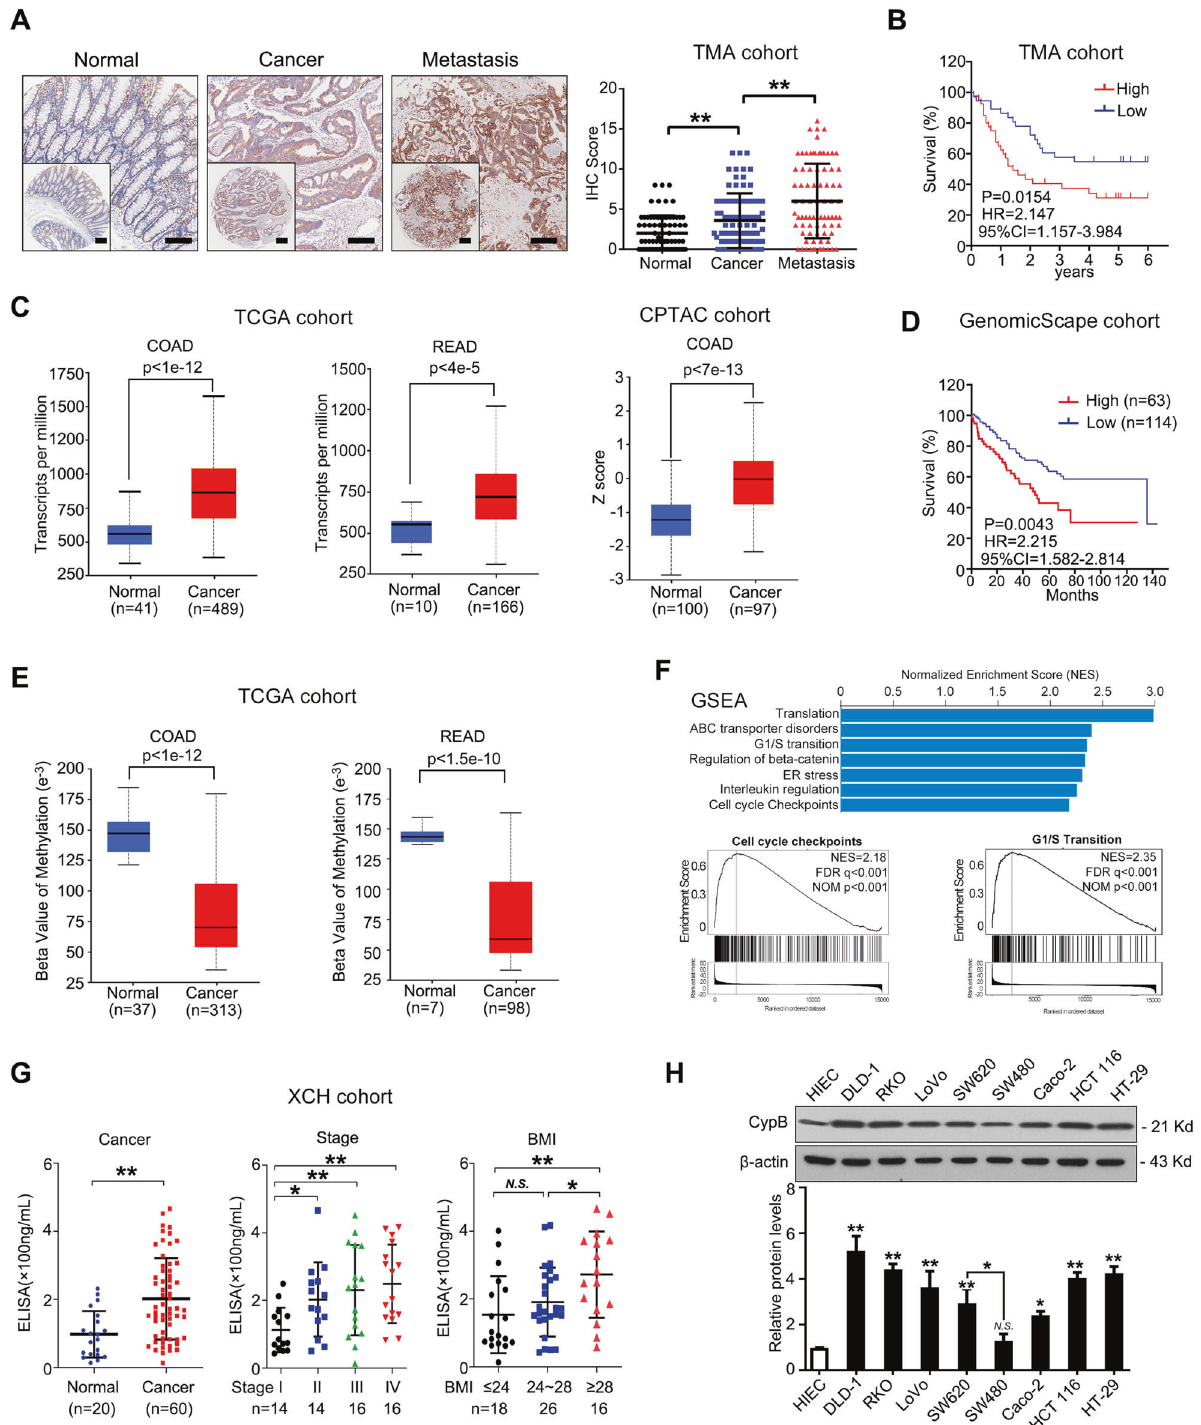
Fig. 1 CypB is upregulated in CRC and predict poor survival. A Left: Representative images of IHC staining of CypB in a CRC tissue microarray containing paired tissue of primary tumors, adjacent normal tissues and metastatic lymph nodes ( n = 80). Scale bars: 200 μ m (main) and 500 μ m (inset); Right: IHC scores of tissue arrays. B Kaplan-Meier curves of CRC patients of TMA cohort with low vs high expression of CypB ( n = 80; P = 0.0154, HR = 2.147, 95% CI = 1.157 – 3.984). C Left: CypB levels in TCGA data of colon adenocarcinoma (COAD, P < 1e-12) and rectal adenocarcinoma (READ, P < 4e-5). Right: CypB levels in CPTAC data of COAD ( P < 7e-13). D Kaplan-Meier curves of CRC patients with low vs high expression of CypB ( n = 286; P = 0.0657, HR = 1.485, 95% CI = 0.951 – 2.169). E DNA methylation levels of CypB promoter of COAD and READ in TCGA cohorts. F Integrative GSEA analysis showing NES of CypB towards pathways in TCGA COAD and READ datasets (top). Enrichment plot of cell cycle checkpoints and G1/S transition (bottom). G Left: CypB levels in serum derived from healthy volunteers ( n = 20) and CRC patients ( n = 60). Middle: The levels of CypB in serum from CRC patients were divided by tumor stage. Right: CypB levels in serum derived from CRC patients were divided by BMI. H Immunoblot for CypB in 8 human CRC cell lines and HIEC cells. The data are presented as the means ± SDs. * P < 0.05; **, P < 0.01; N.S. not signi fi cant. Cell Death and Disease (2022)